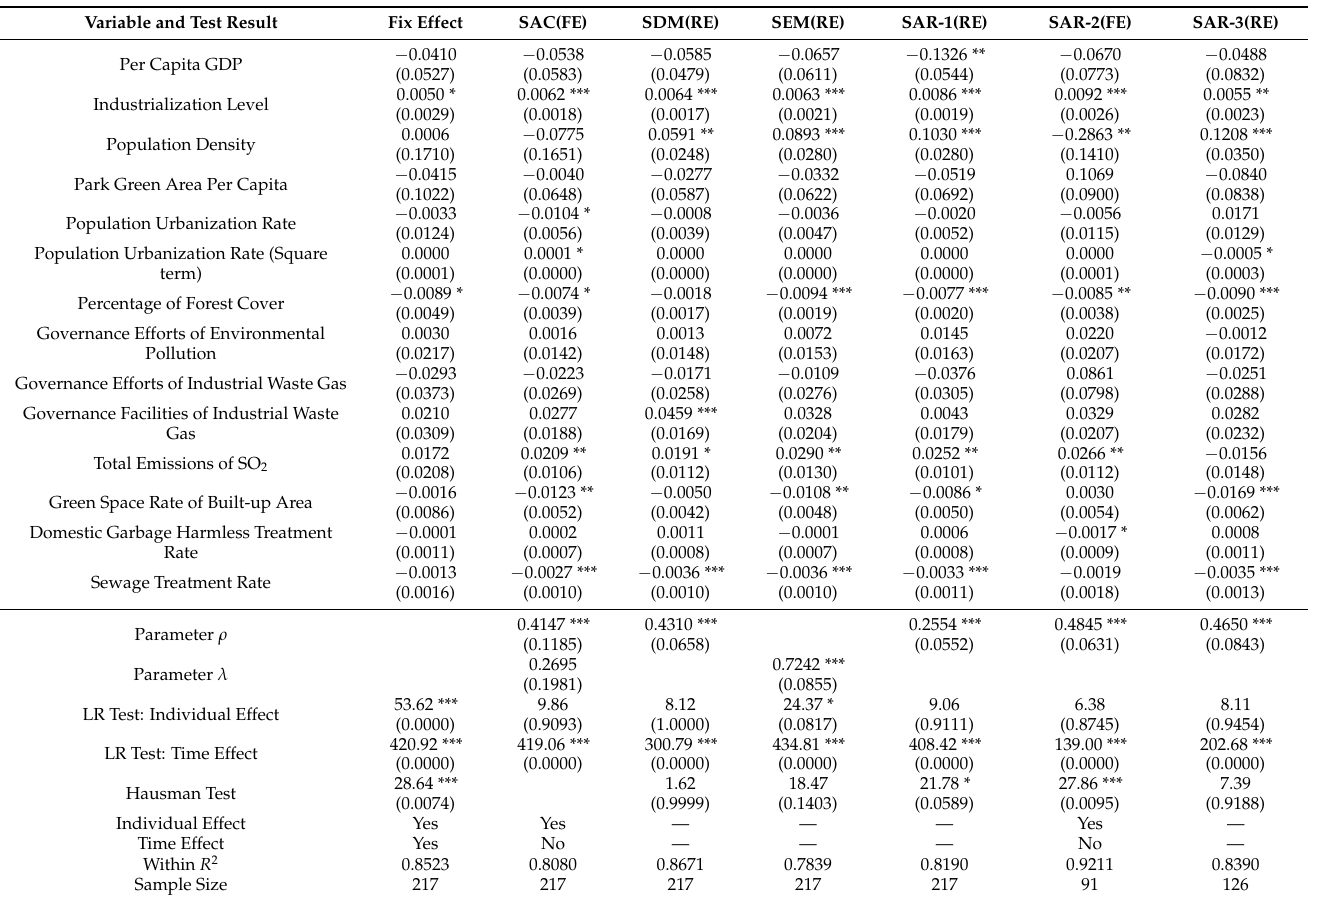
Table 4. Estimation results of econometric